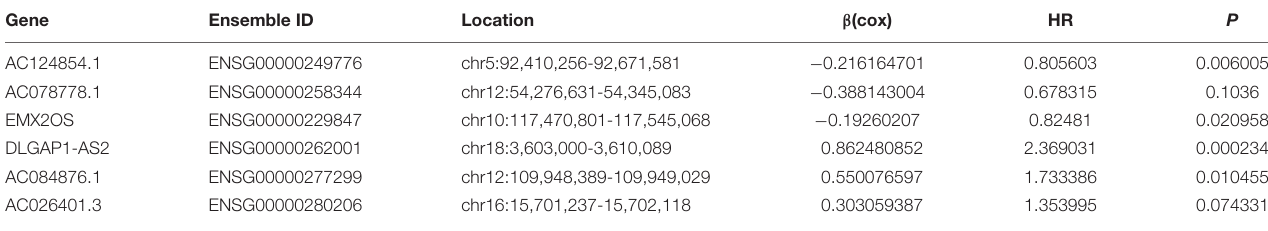
TABLE 2 | The information of target lncRNAs from the multivariate cox regression